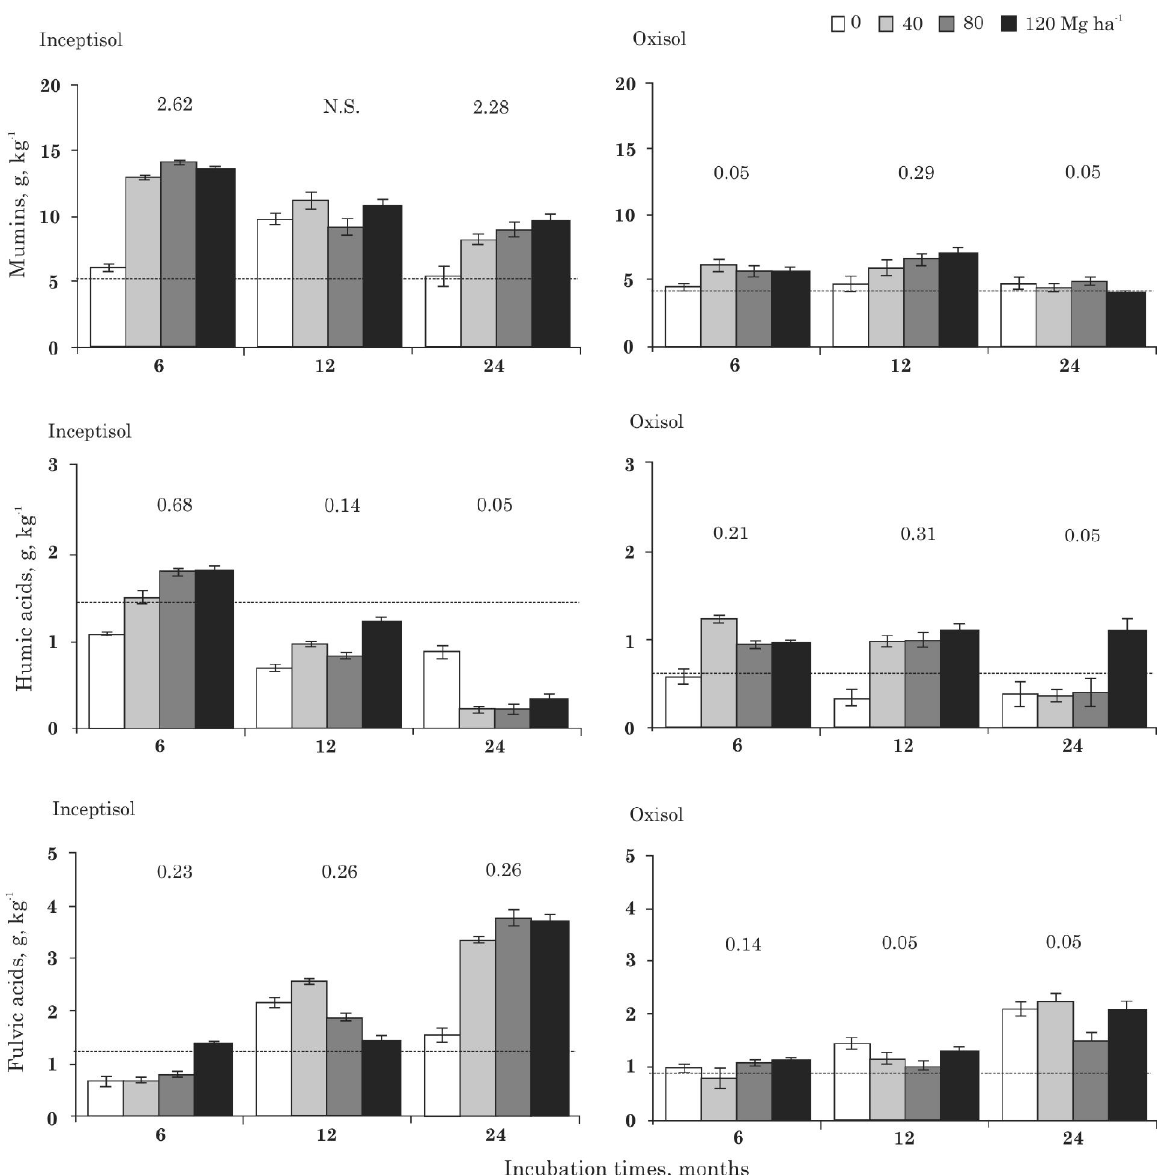
Figure 3. Humic fractions content in Inceptisol and Oxisol samples with time for different doses of filter cake application. Error bars represent the standard error of the mean. Horizontal dashed line represents values for untreated soil at the beginning of the experiment. Numbers refer to least significant difference (Tukey test, p <